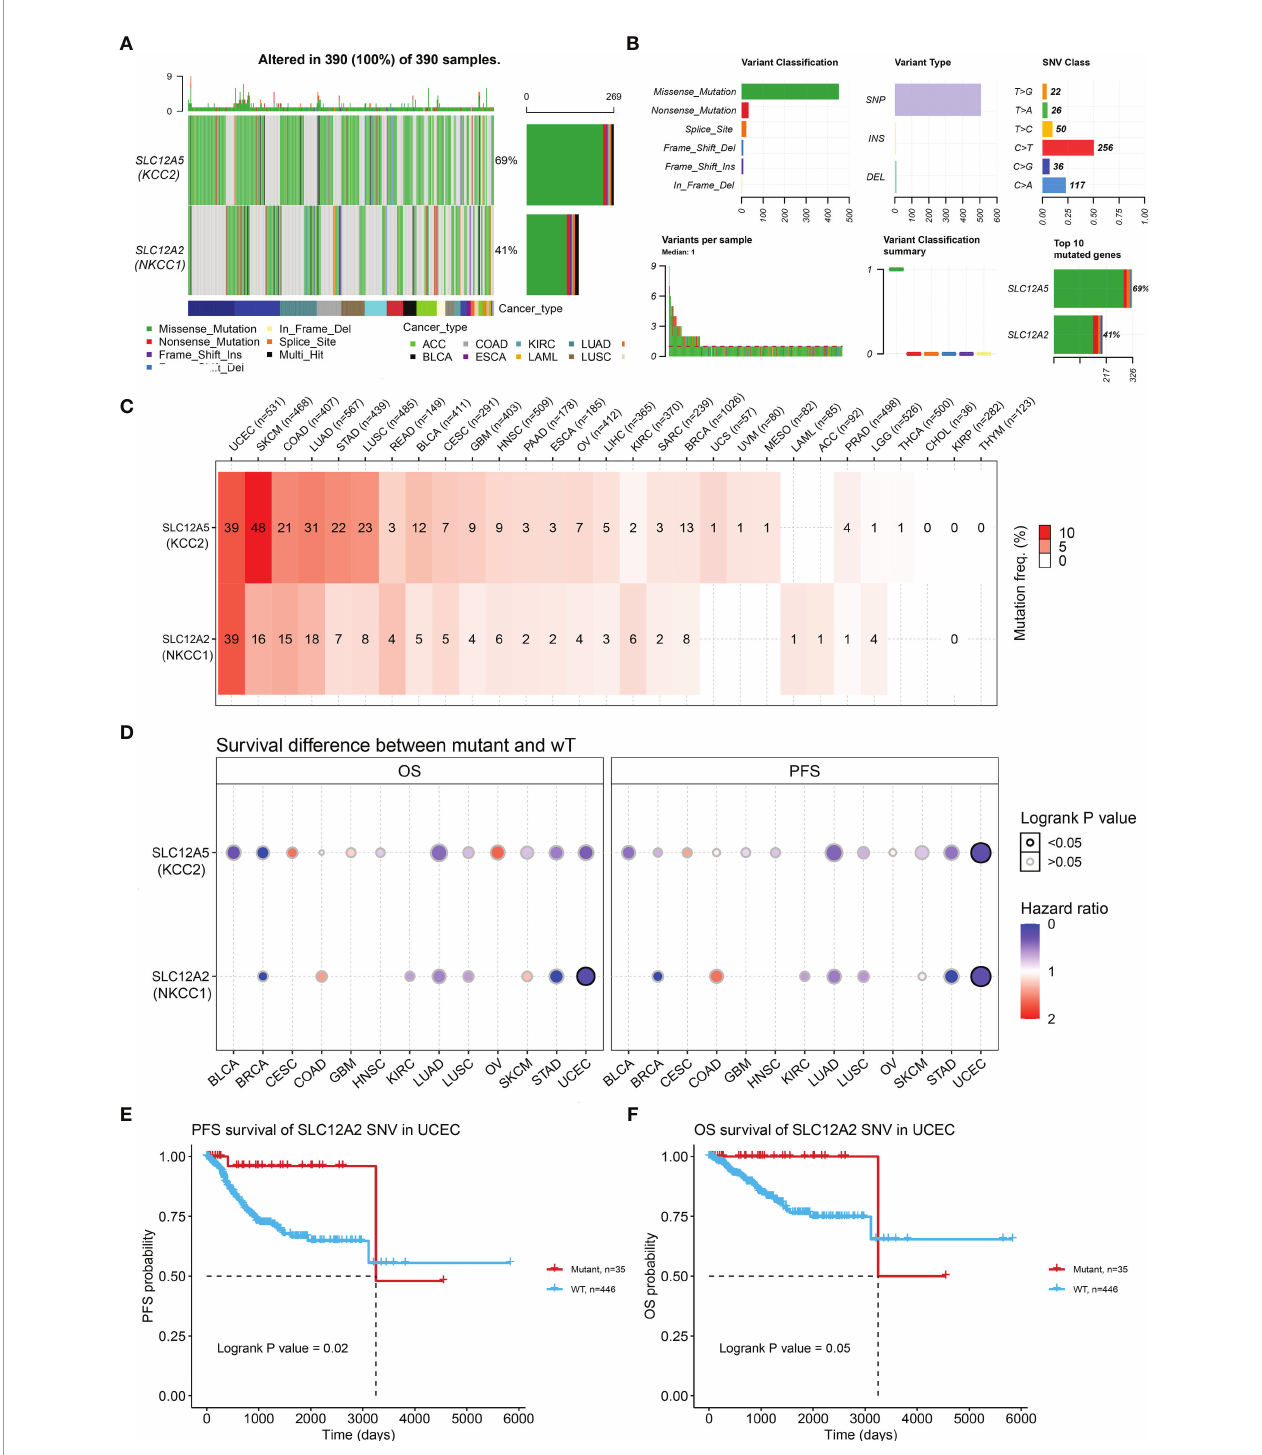
FIGURE 6 | KCC2 and NKCC1 mutation analysis in pan-cancer from TCGA. (A) Common gene mutation frequency in pan-cancer was explored according to differential KCC2 and NKCC1 expression in 390 cases. (B) The variant classi fi cation, variant type, and SNV category of KCC2 and NKCC1. (C) The mutation frequency of KCC2 and NKCC1. UCEC (39%), SKCM (48% for KCC2, 16% for NKCC1), COAD (21% for KCC2, 15% for NKCC1), LUAD (31% for KCC2, 18% for NKCC1), and STAD (22% for KCC2, 7% for NKCC1). (D) The effects of wild-type and mutant types of KCC2 and NKCC1 on the prognosis of cancer patients. (E) The PFS survival prognostic value of NKCC1 mutations for UCEC patients ( p = 0.02). (F) The OS survival prognostic value of NKCC1 mutations for UCEC patients ( p =